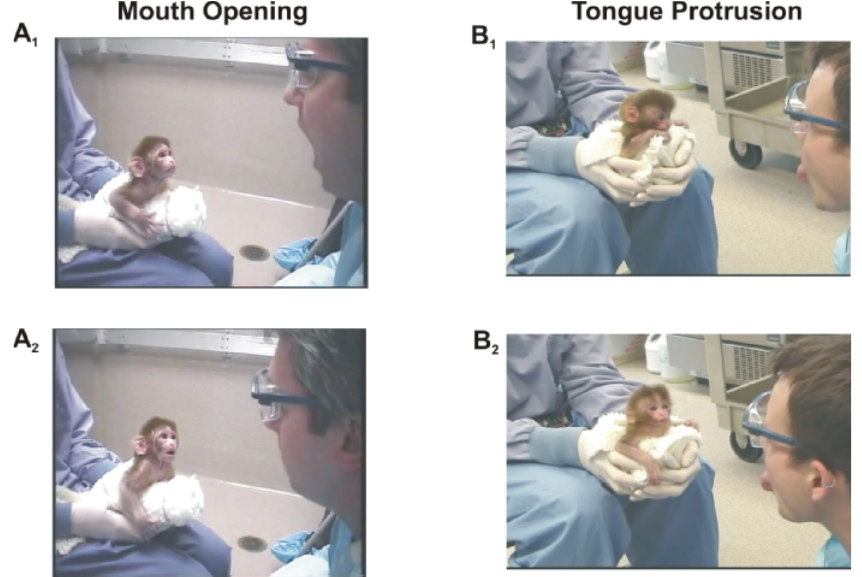
Figure 4. Two Examples of a Monkey’s Response to the Stimuli Mouth Opening and Tongue Protrusion MO is shown on the left; TP on the right. Figures were taken from Videos S1 and S2. Frame A1 was taken 21.12 s after frame A, whereas frame B2 was taken 13.38 s after frame B. DOI: versus MO condition: z ¼ 2.36, p , 0.03; versus LPS condition: z ¼ 2.54, p , 0.01; versus HO condition: z ¼ 1.95, p , 0.05; versus EYE condition: z ¼ 2.65, p , 0.01).